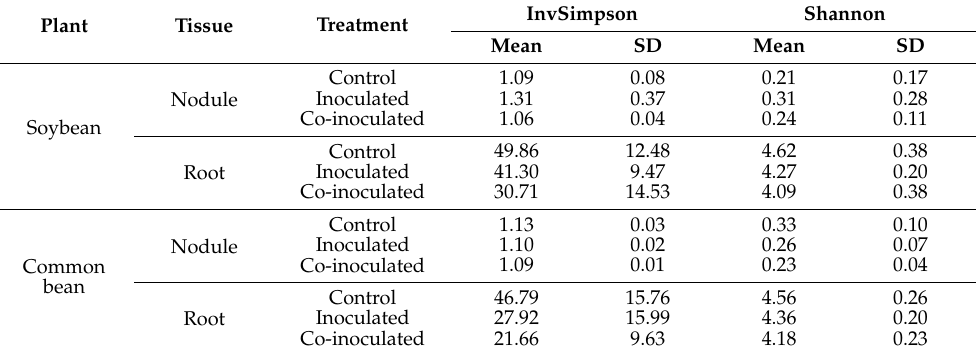
Table 3. Bacterial alpha-diversity indexes in the microbiomes of roots and nodules of common bean and soybean non-inoculated (control); inoculated with specific rhizobia; and co-inoculated with rhizobia and Azospirillum brasilense